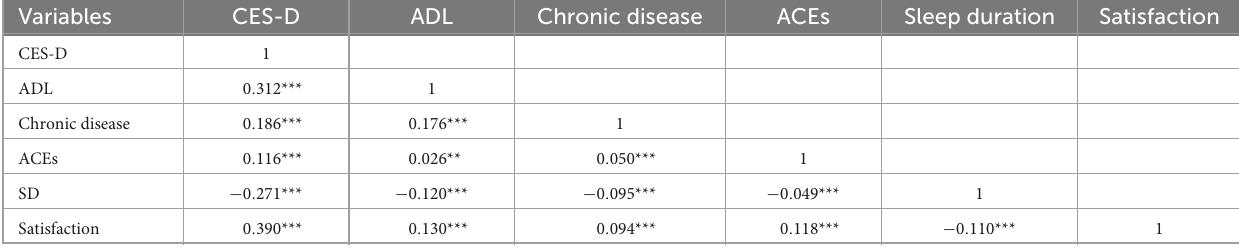
TABLE 3 Correlation coefficients between key study variables ( N = 14,693).